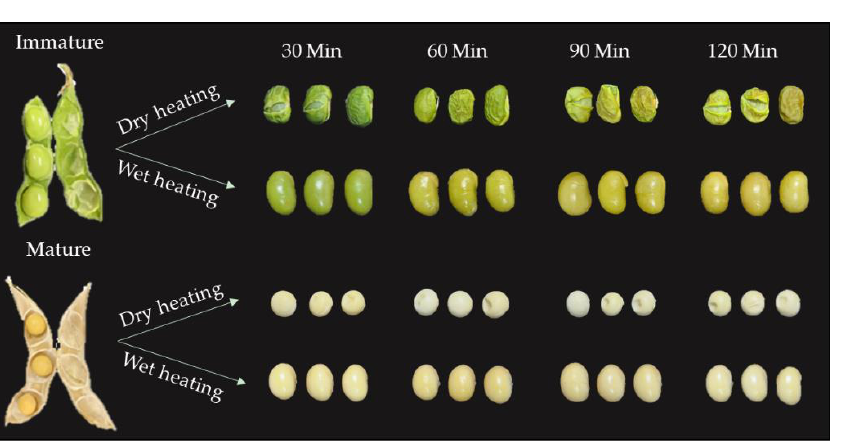
Figure 1. Morphologies of immature and mature soybeans after dry- and wet-heating for different